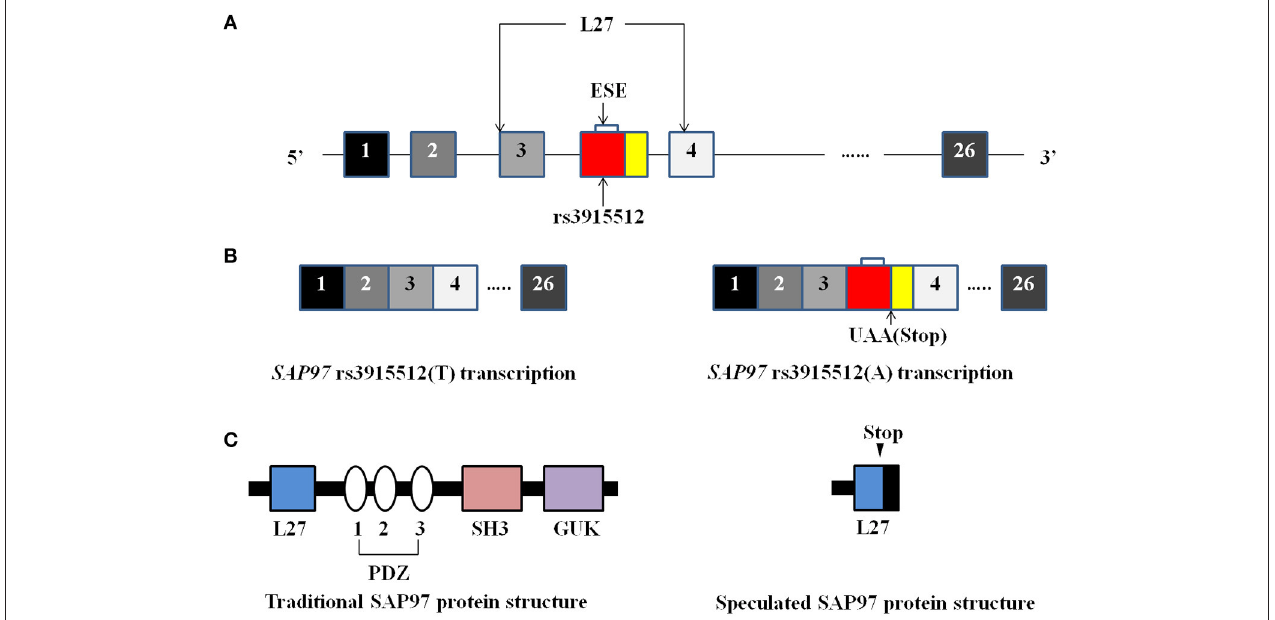
FIGURE 1 | The structure of the human SAP97 gene, transcripts and proteins. (A–C) Schematic representation of the structure of the human SAP97 gene (A) , transcripts (B) , and protein (C) . When the SNP rs3915512 consists of the T allele, the SAP97 gene sequence does not meet the exonic splicing enhancer (ESE) consensus and the SAP97 transcript sequence and protein structure was shown on the lower left side of the figure. When the SNP consists of the A allele, an extra exon might insert the transcript because of the ESE consensus. Due to the stop codon in the extra exon, the splicing variant will truncate the SAP97 protein which was shown on the lower right side of the figure. [This figure was improved on the basis of the study by Uezato et al. ( 10)].